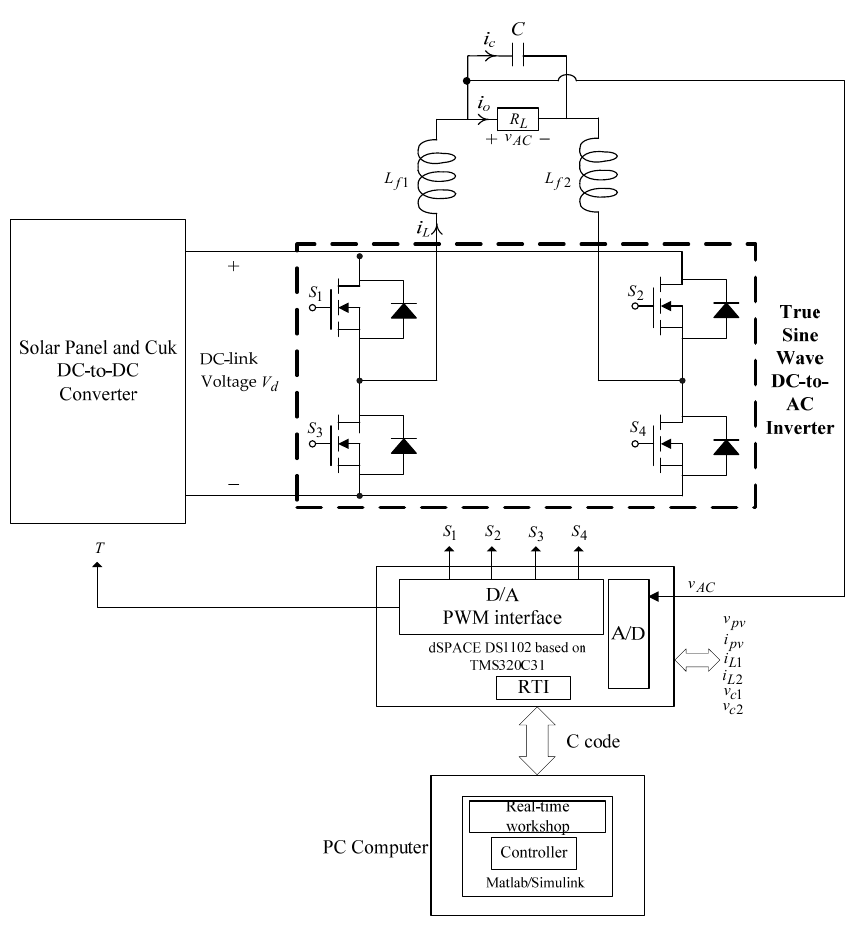
Figure 2. Circuit structure of a true sine wave DC-to-AC inverter.